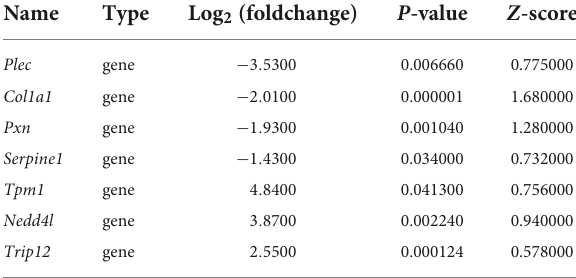
TABLE 4 Summary of key TFs and